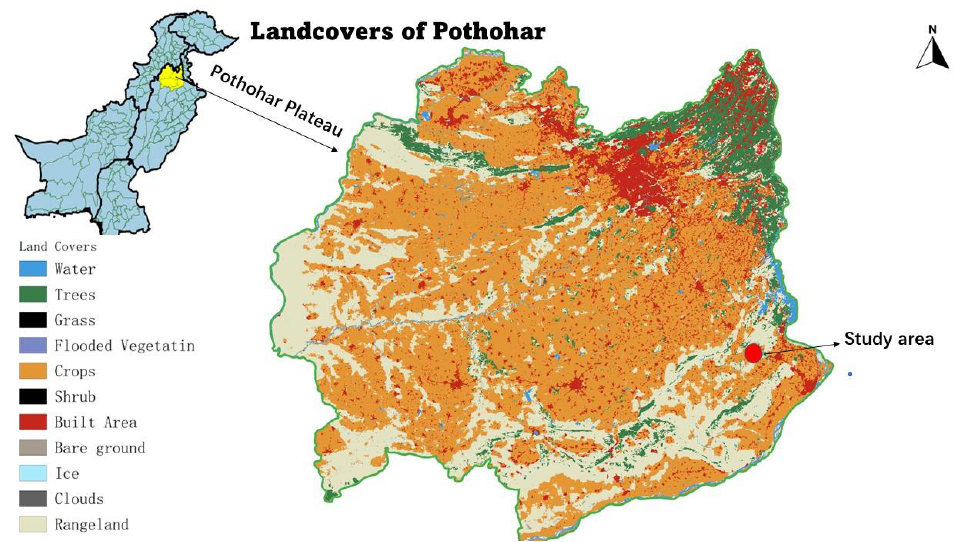
Figure 1. Land cover map of the rainfed Pothohar region of Pakistan.